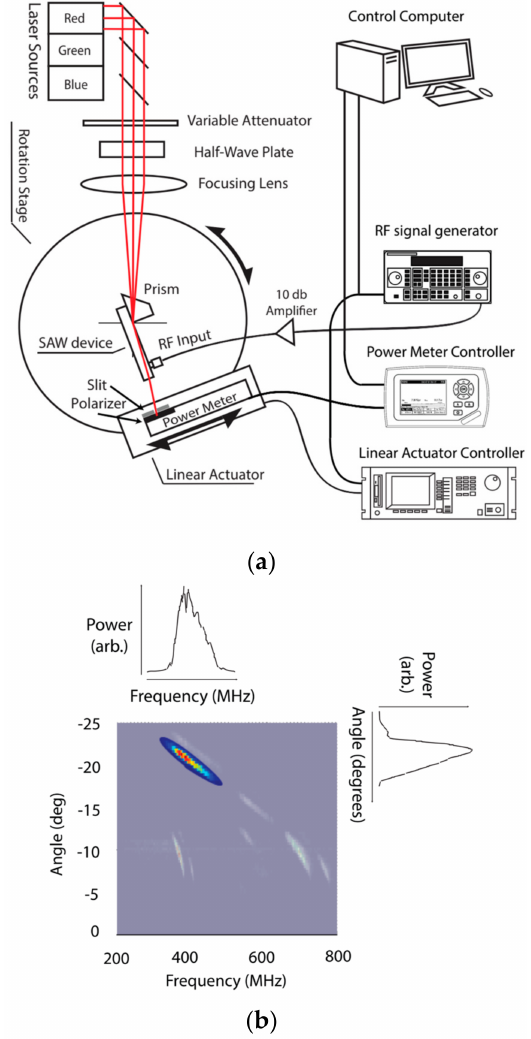
Figure 9. ( a ) Semiautomatic characterization apparatus. ( b ) Output of a semiautomatic characteriza- tion apparatus for leaky mode devices. Reprinted with permission from [41] ©